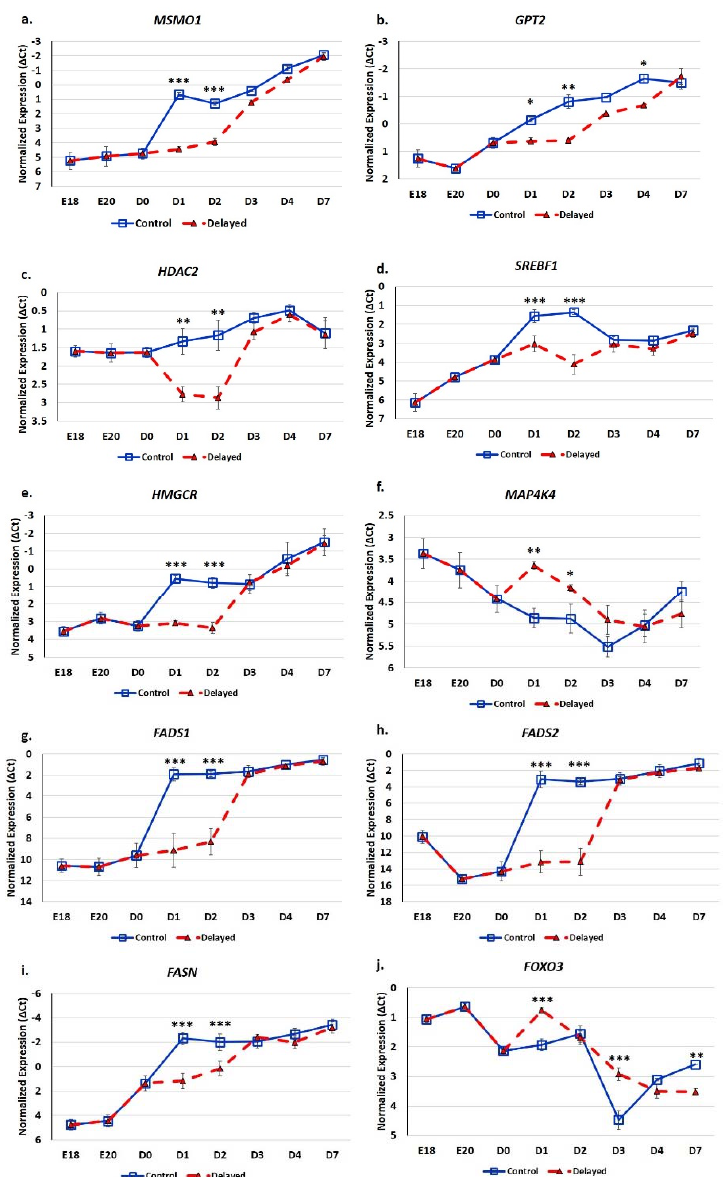
(Figure 7i). Potential regulatory proteins, with multiple hits in the hepatic prey library, which likely regulate the hepatic expression of FASN in chickens, include SRF (8 clones), PKNOX1 (10 clones) and HDAC2 (16 clones).